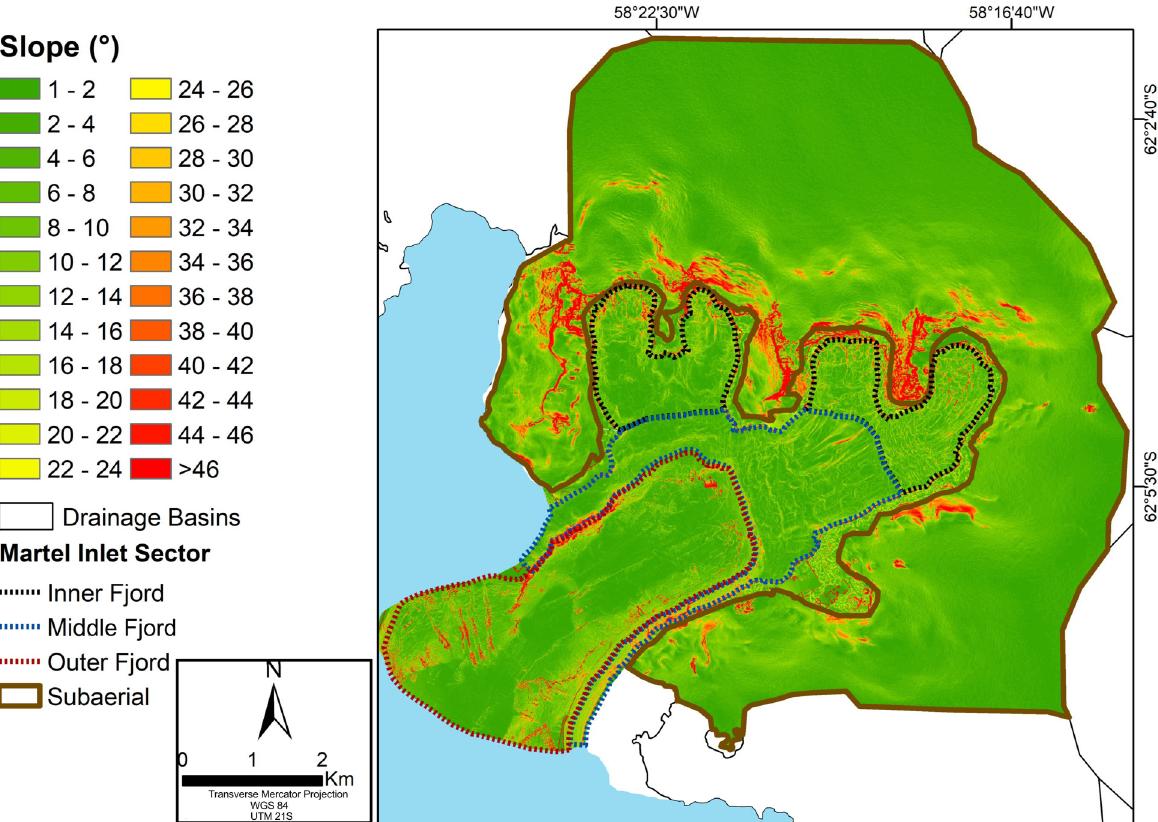
Figure 5. MI submarine and subaerial slope